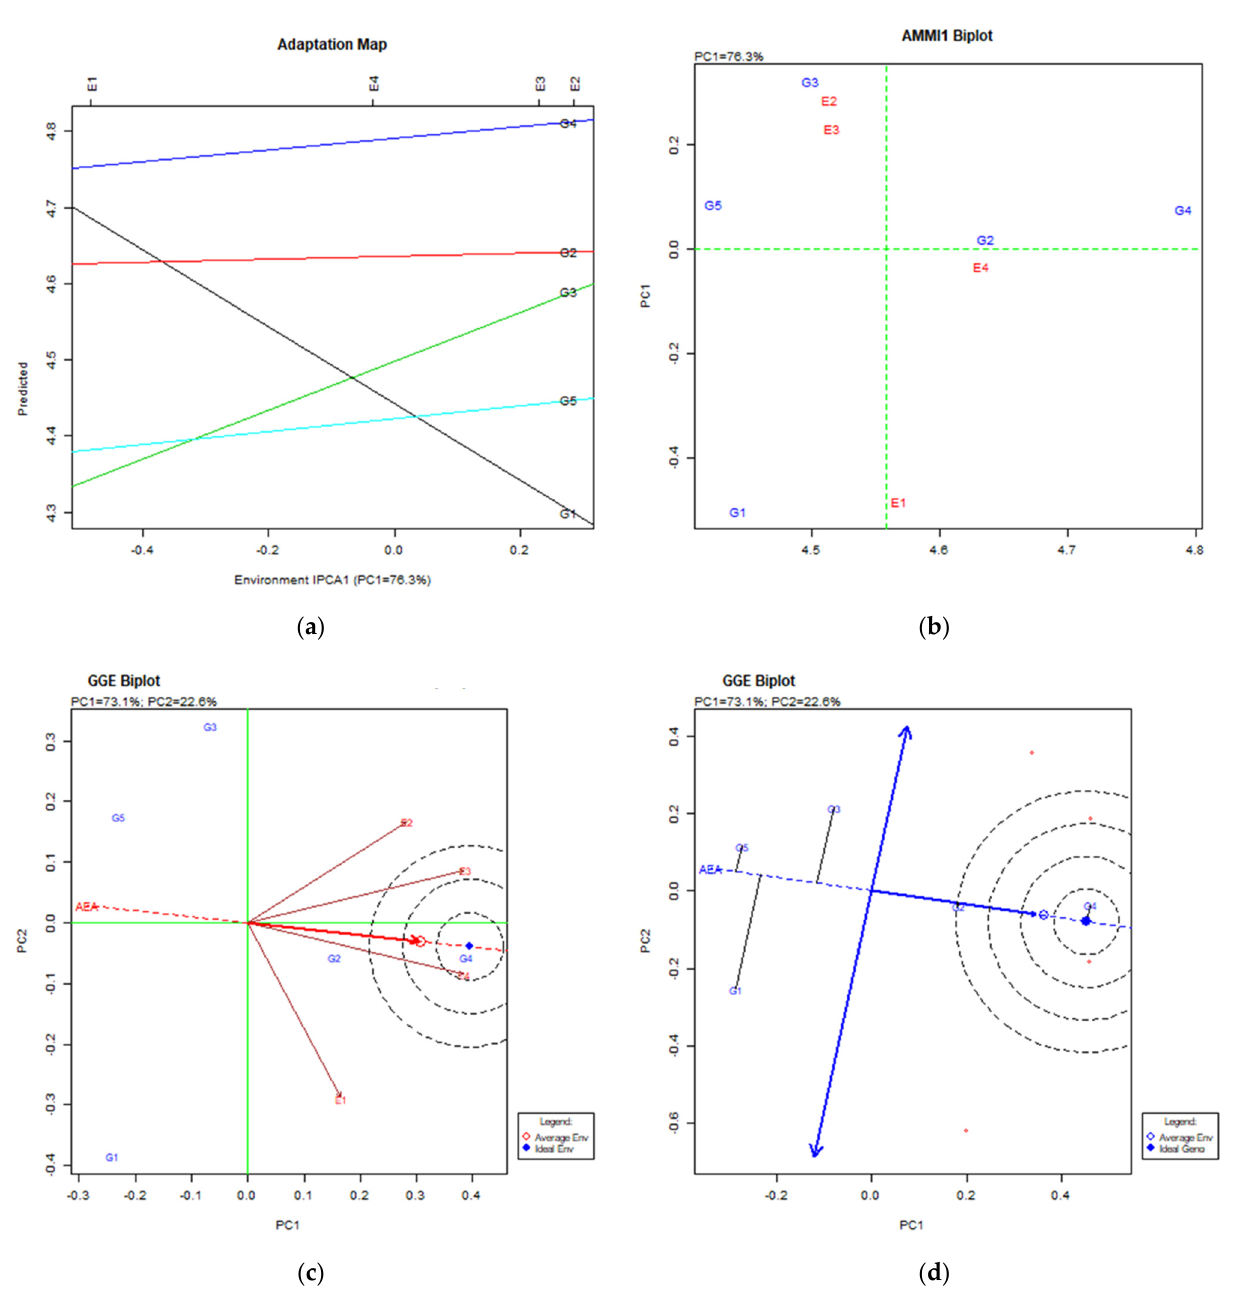
Figure 7. Stability analysis for number of seeds per pod based on: ( a ) the adaptation map where the X-axis (PC1) visualizes the stability of cultivars over environments and the Y-axis—the performance of cultivars for the trait; ( b ) the AMMI1 biplot where the Y-axis is the one visualizing the trait performance and the X-axis (PC1) visualizes the stability of cultivars over environments; ( c ) the GGE biplot for environments depicting the stability of the environments over years via the placement as near as possible to the ideal and average environment; ( d ) the GGE biplot for cultivars depicting the stability of the cultivars over environments where the productive cultivars are those to the right on the AEA vector and the stable ones are those which are as close to the AEA axis as possible.